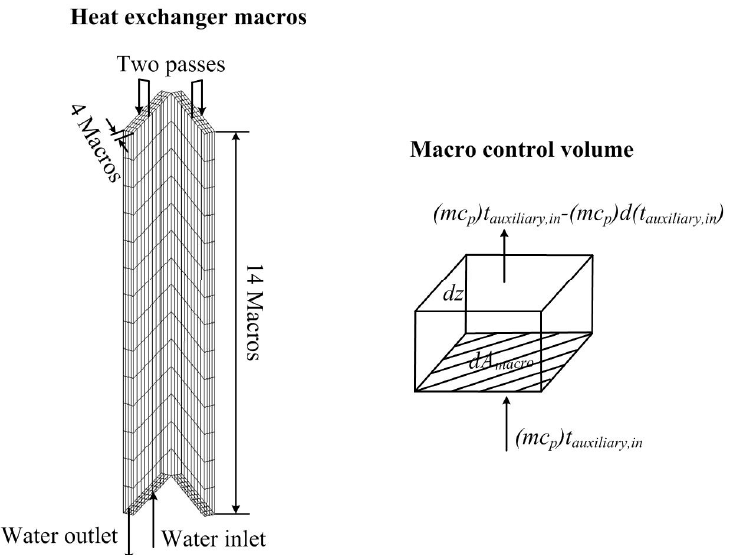
Figure 2. Heat exchanger macros and macro control volume.